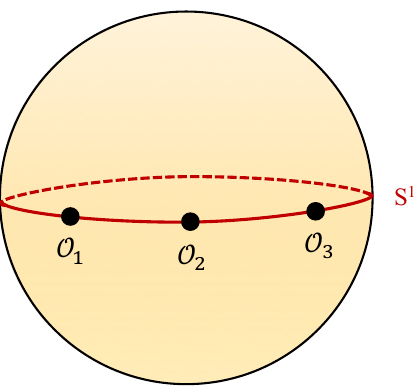
Figure 1 . A collection of Higgs/Coulomb branch operators O i along a great circle S 1 in the S 3